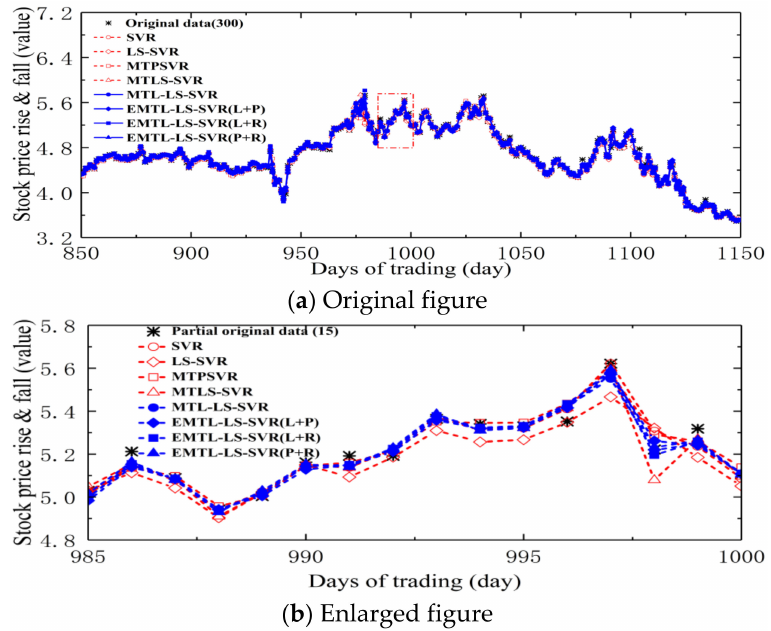
Figure 9. Predictions of different regression models on stock opening price for ICBC ( a ) Original figure, ( b ) Enlarged figure.